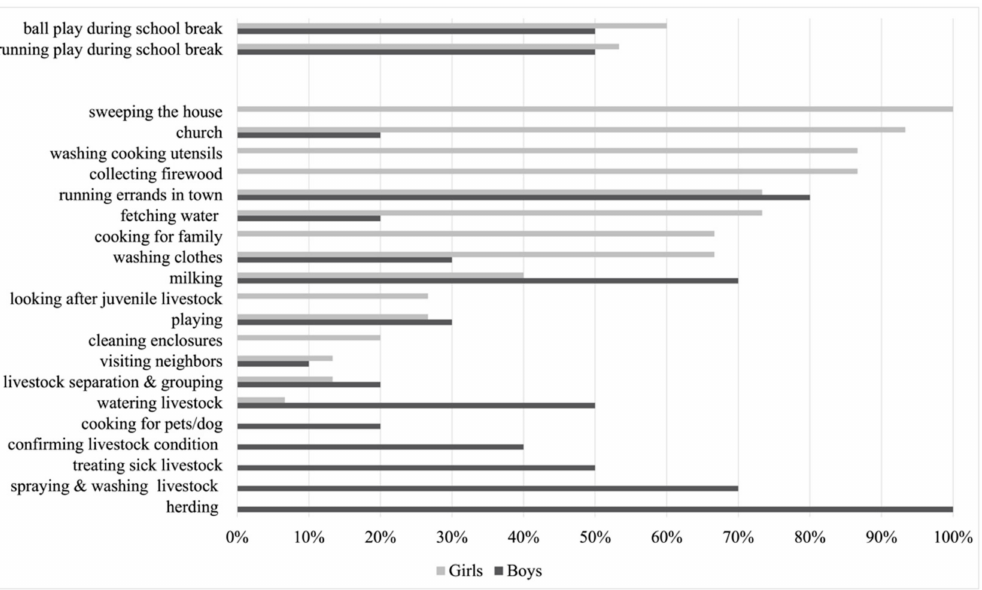
Figure 3. Daily activities of Maasai children, distinguished by